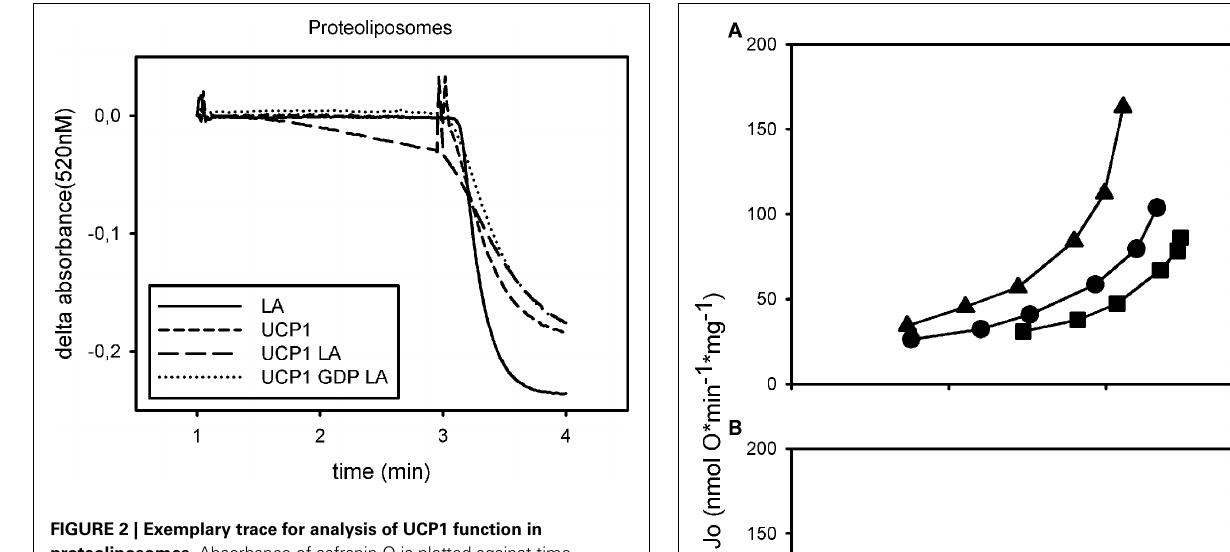
FIGURE 2 | Exemplary trace for analysis of UCP1 function in proteoliposomes. Absorbance of safranin O is plotted against time. Addition of nigericin at minute 1 induces polarization of the liposomes, measured as a decrease in safranin O absorbance, if a proton translocating pathway is present in the vesicles. Addition of CCCP at minute 3 leads to complete polarization and indicates vesicle volume.The initial slope after addition of nigericin is a measure for the proton translocation pathway, if there is one present and active. UCP1 is not active under basal conditions (UCP1) but mediates proton transport in the presence of lauric acid (LA). This can be prevented by addition of GDP (GDP LA). Addition of lauric acid to vesicles not containing UCP1 does not induce proton translocation (LA).